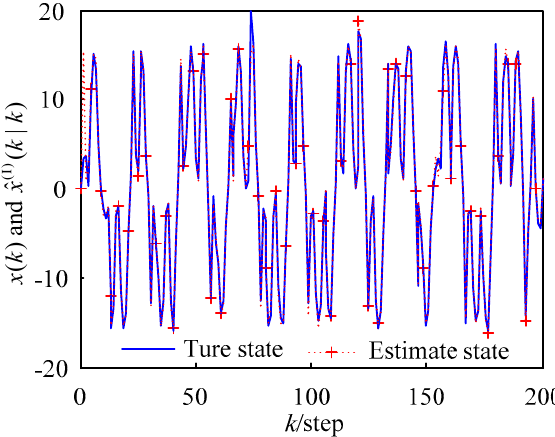
Figure 2. Curves of the true values and estimates using the WMF-PF1.